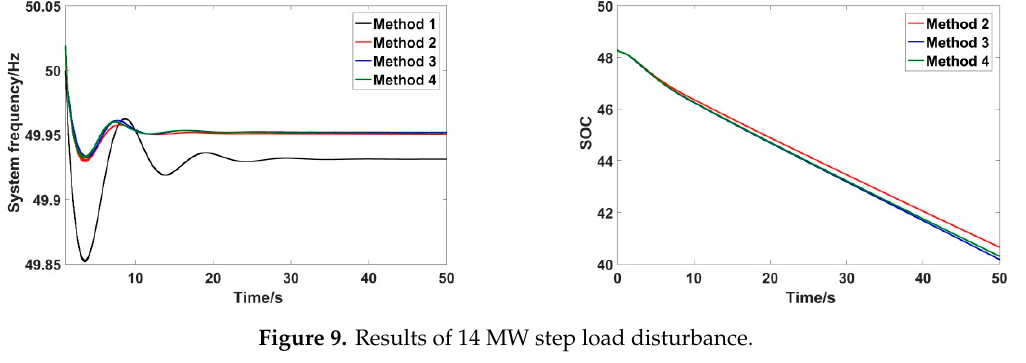
Figure 8. Results of 13 MW (megawatts) step load disturbance.